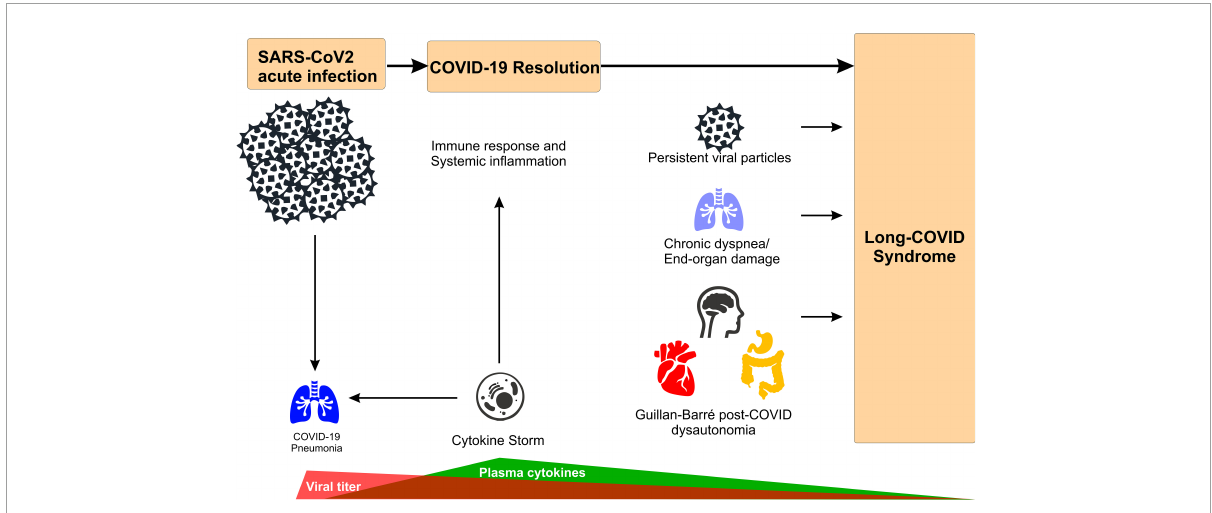
FIGURE1 Main mechanism of long-COVID syndrome. Acute SARS-CoV-2 infections leads to broad inflammatory response (i.e., cytokine storm) to combat viral infection that causes COVID-19 pneumonia. After infection resolution, potential mechanisms underlying long-COVID syndrome include: (i) remanent viral particles in several tissues/organs, (ii) chronic dyspnea associated with lung function impairment (i.e., hypoperfusion, focal ischemia), and (iii) Guillan-Barré-like dysautonomia post-COVID, characterized by depression/anxiety behavior, excessive daytime fatigue, cardiac arrhythmogenesis, orthostatic hypotension and digestive system